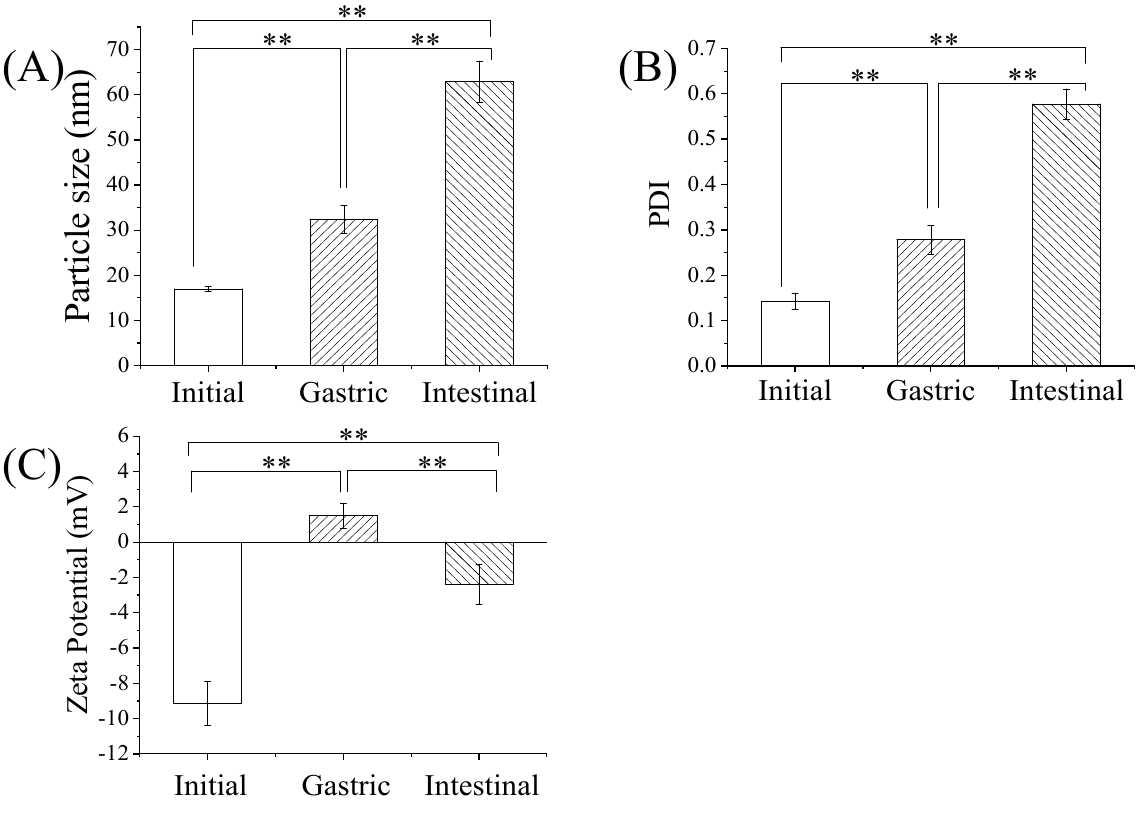
Figure 3. The effects of simulated gastrointestinal tract digestion on the physical characteristics of GME. Mean particle size in nm ( A ), polydispersity index ( B ), and zeta potential (mV) ( C ) of GME at the initial, gastric, and intestinal phases., ** p ≤ 0.01.